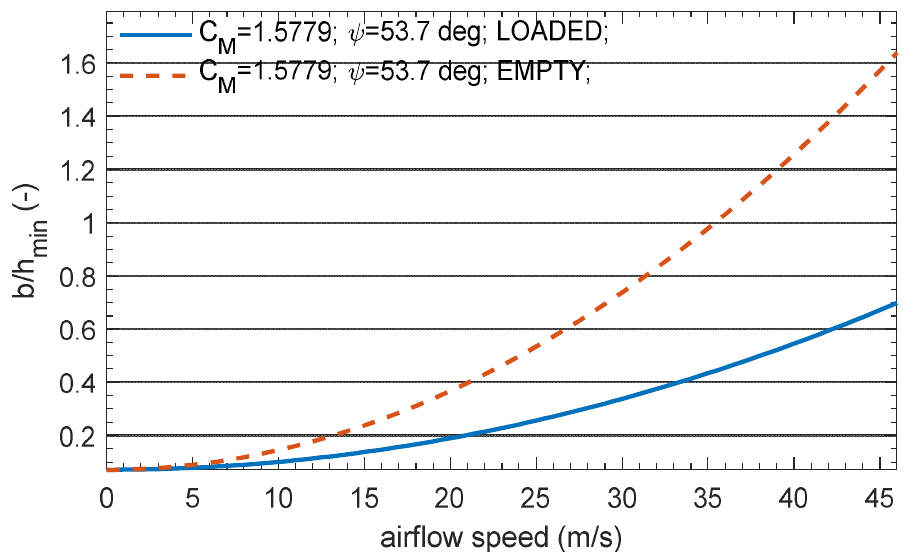
Figure 10. Relationships between half-track width b and height of the mass centre h , meeting the safety condition (Equation (6)) vs. airflow speed, C M —aerodynamic coefficient, ψ —yaw angle of the relative airflow velocity.